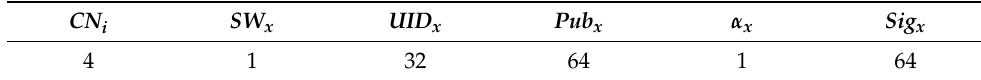
Table 2. Voting message sizes (bytes).